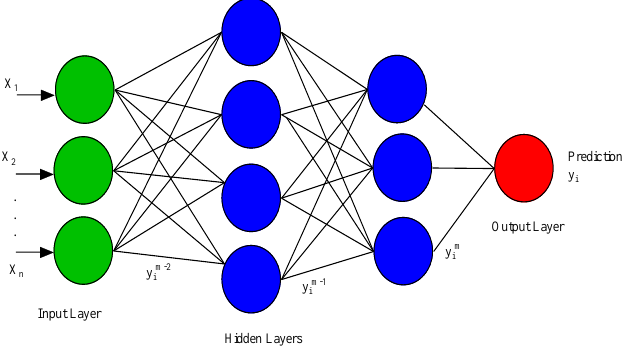
Figure 3. A simple structure of neural networks — input layer in green, output in red, and the hidden layers in blue.